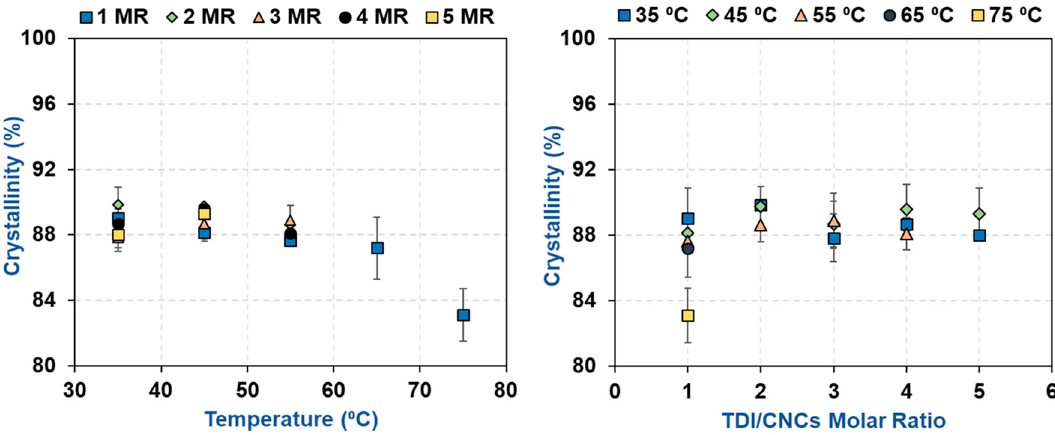
Figure 6. The impact of carbamation temperature and TDI/CNCs molar ratio on the crystallinity of CNCs upon carbamation.